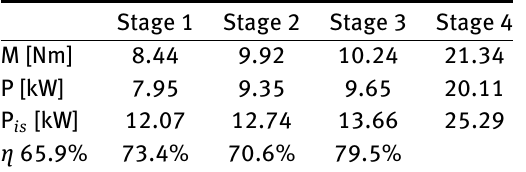
Table 1: Efficiency in the four stages of the investigated ORC turbine. Stage